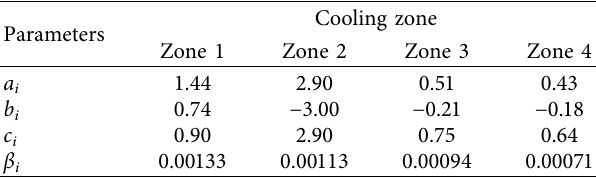
Table 2: Secondary cooling control parameters.